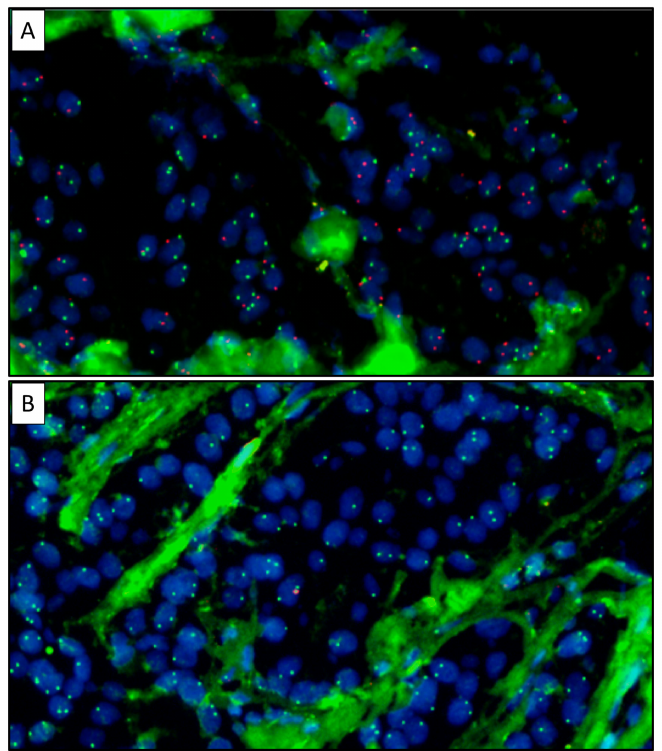
Figure 2. Representative images of male BC cases with XY ( A ) and LOY ( B ), both at a 40 × magnification. The cell nuclei are depicted in blue (dapi), the X-chromosome is depicted in green (FITC), and the Y-chromosome is depicted in red (Texas